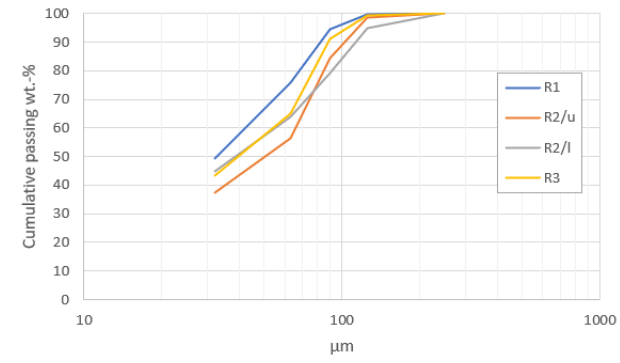
Figure 4. Particle size distributions for composite samples after comminution. Table 2. Chemical data (Sc 2 O 3 in ppm, other oxides in wt%) for individual Kiviniemi drill core samples from R1, R2/u, R2/l and R3 as determined with ICP-OES. Calculated weighted averages for composite feed samples are shown. Duplicate (d) results for R1, 47.0–48.0 m and R3, 91.5–93.0 m, are also shown.